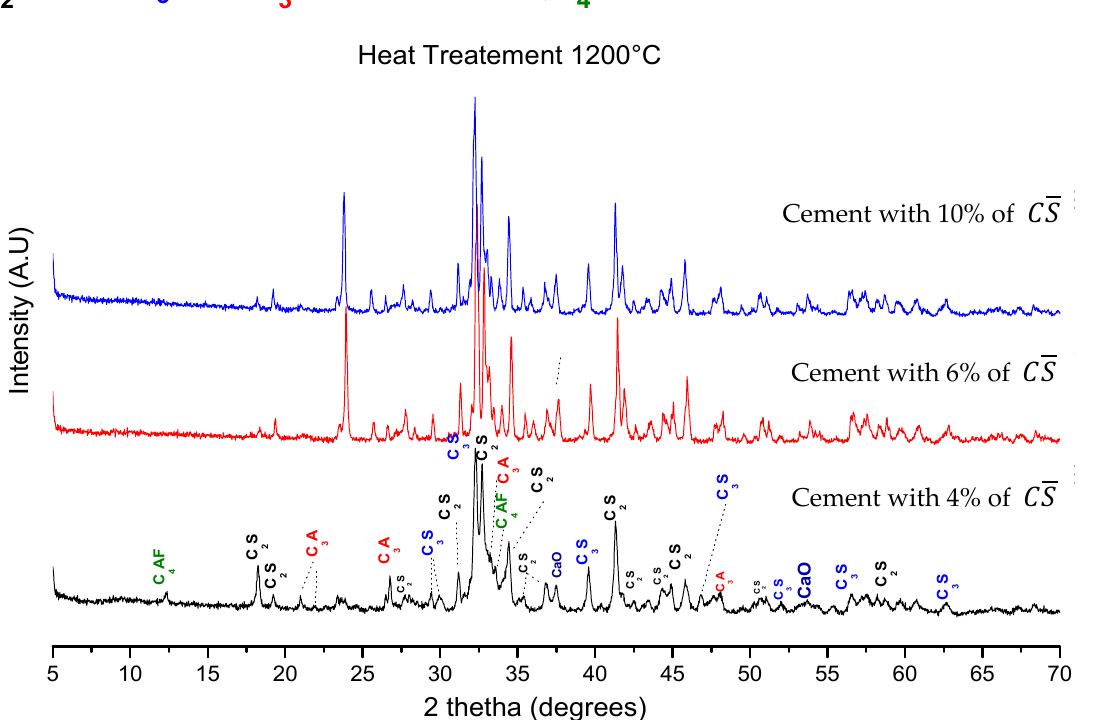
Figure 7. Diffraction patterns of cement produced by indirect mechanosynthesis at different heat treatments.